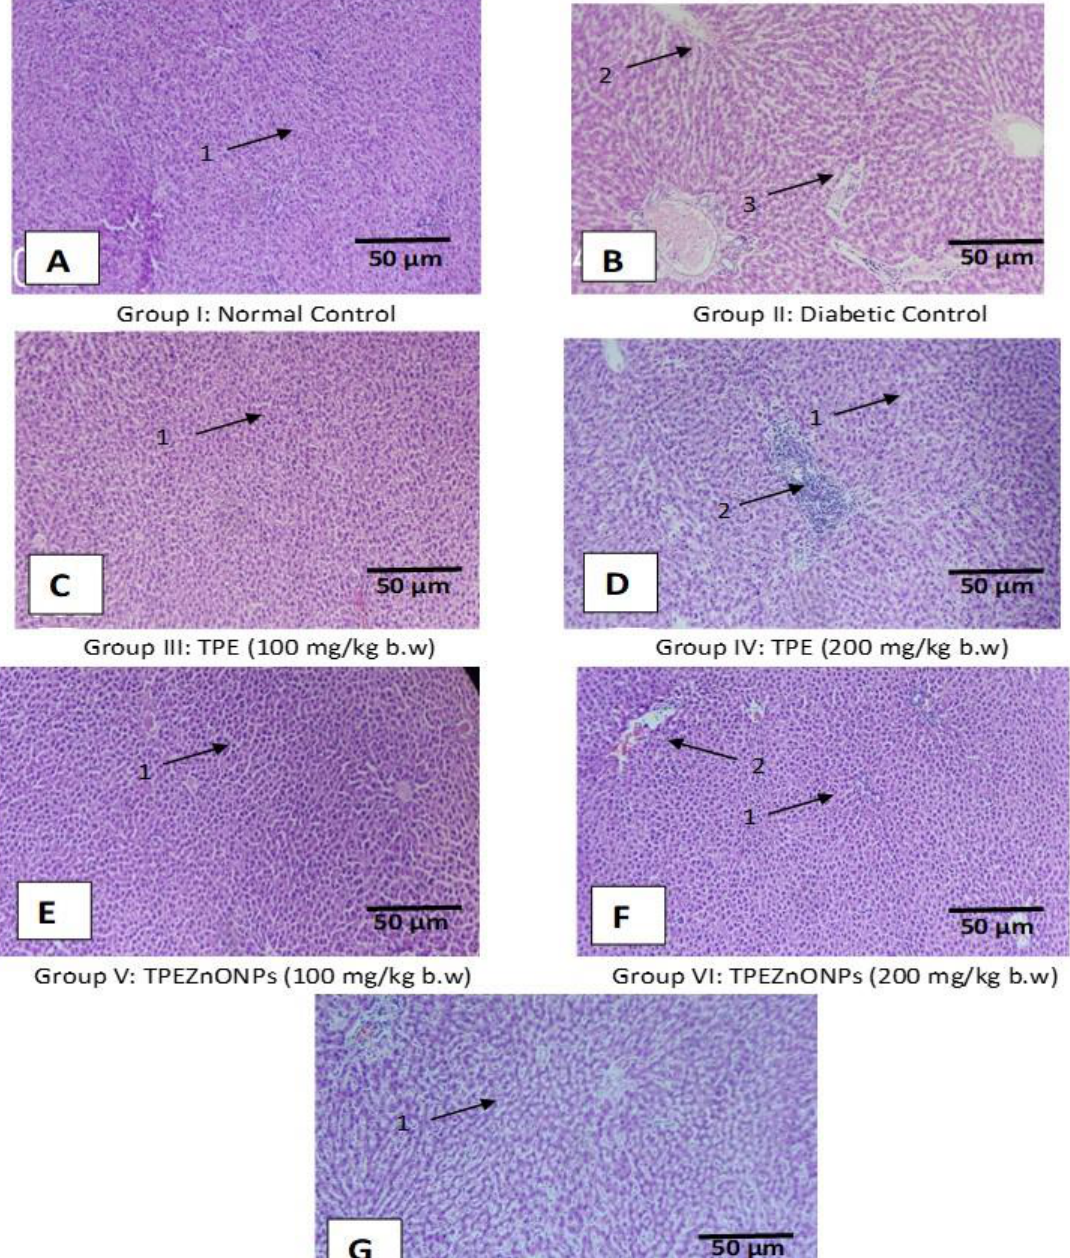
Figure 10. The liver section of histology stained with hematoxylin and eosin (Scale bar 50 μm, 100× magnification). ( A ) Group I: Normal control, ( B ) Group II: Diabetic control (received STZ), ( C ) Group III: TPE (100 mg/Kg bw), ( D ) Group IV: TPE (200 mg/Kg bw), ( E ) Group V: TPE-derived ZnO NPs (100 mg/Kg bw), ( F ) Group VI: TPE-derived ZnO NPs (200 mg/Kg bw), ( G ) Group VII: Glibenclamide (10 mg/Kg bw). Where 1: Normal hepatocyte, 2: mild periportal inflammation, 3: periportal fatty